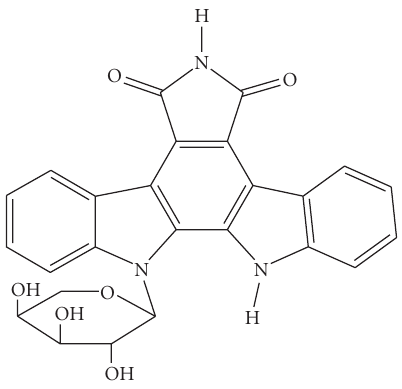
Figure 1: Structure of 12-( α - L